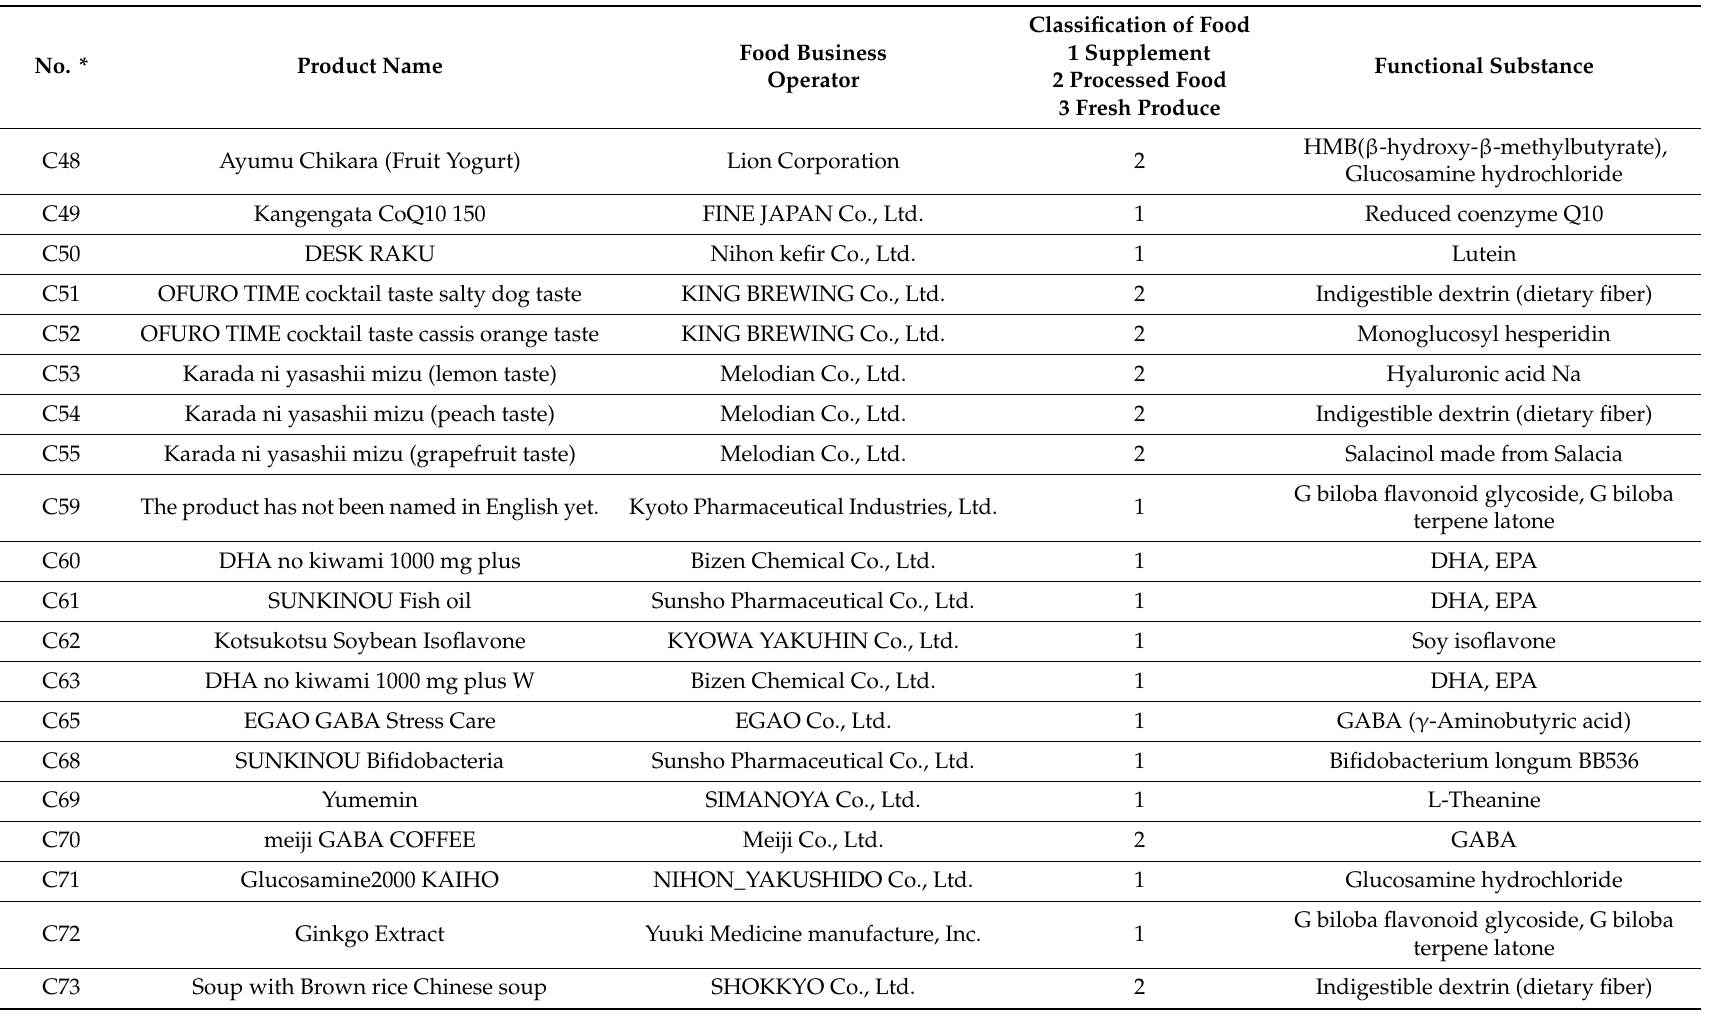
Table 2. Characteristics of systematic reviews of the foods with function